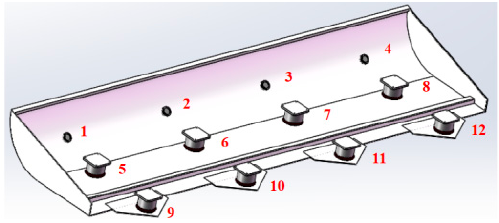
Figure 5. Pressure sensor installation location.